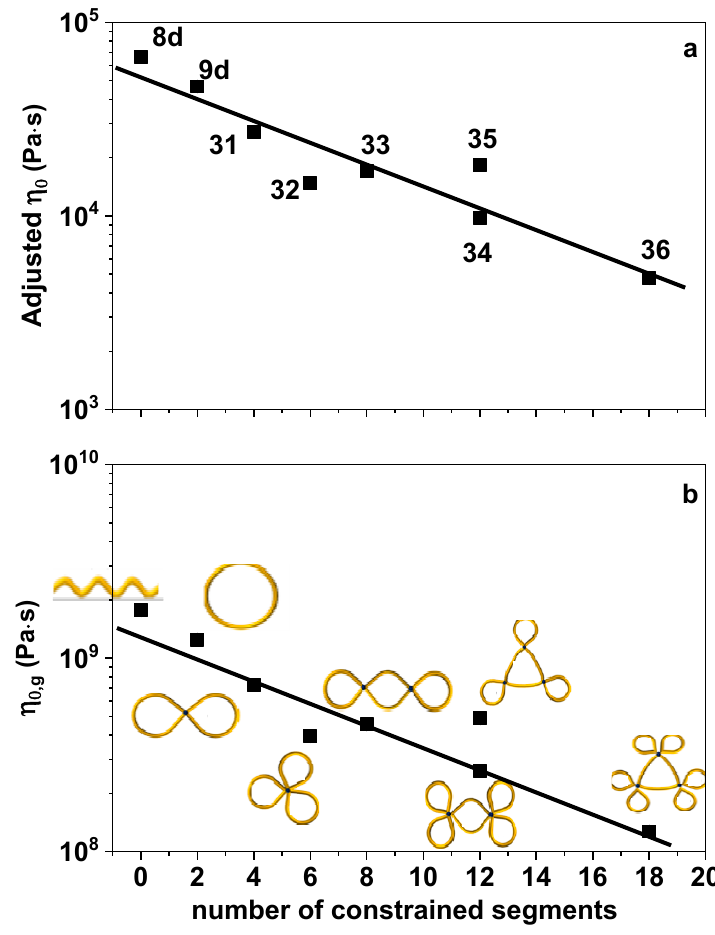
Figure 3. ( a ) The zero-shear viscosity η 0 adjusted to the linear chain’s frictional state, as function of the number of constrained segments of the different multicyclic polystyrenes. The solid curve is the best fit η 0 = A × 10 ( B × constraint ) with B = − 0.057 and A = 5.25 × 10 4 Pas. ( b ) The zero-shear viscosity η 0,g adjusted to the T g of the respective multicyclic polystyrene as function of the number of constrained segments. The solid curve is the best fit η 0 = A × 10 ( B × constraint ) with B = − 0.057 and A = 1.41 × 10 9 Pas.